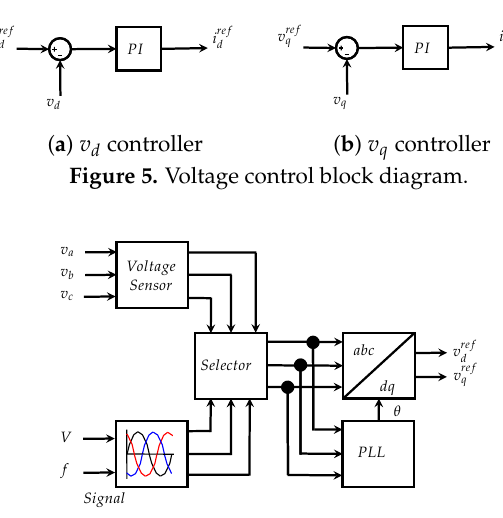
Figure 6. Voltage reference generation